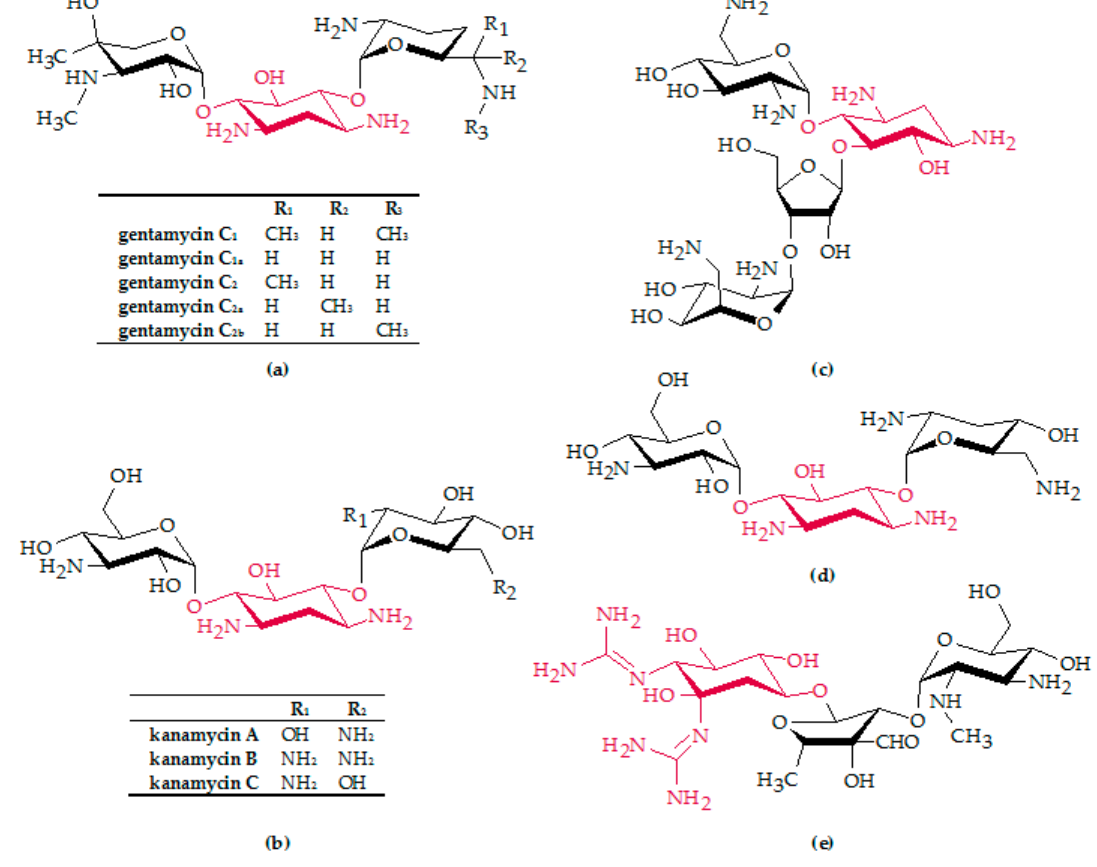
Figure 3. Chemical structure of: ( a ) gentamicin; ( b ) kanamycin; ( c ) neomycin B; ( d ) tobramycin; and ( e ) streptomycin. The basic structure of aminoglycoside antibiotics consists of an aminocyclitol ring (marked in red) which is linked glycosidically to other amino sugars.